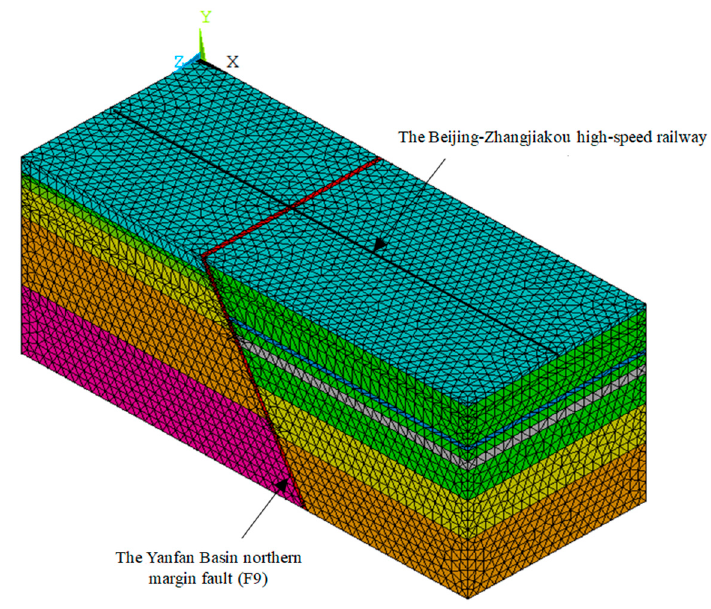
Figure 8. The 3D mathematical mode considering the fault.